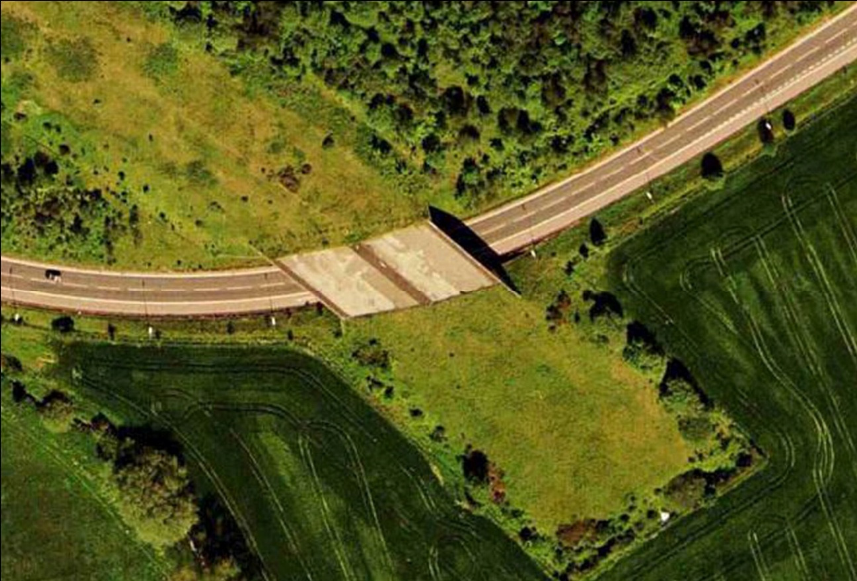
Figure 12. Aerial view showing motorway bridge built as part of proposed